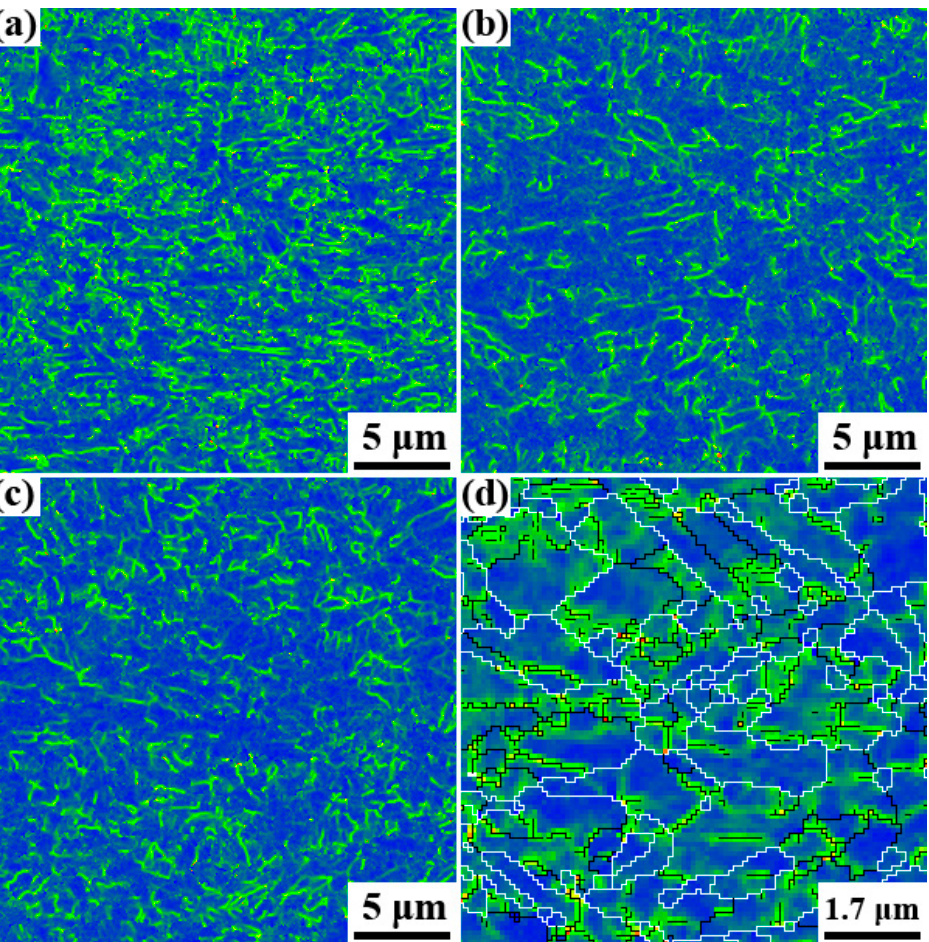
Figure 8. KAM map of specimen A ( a ), specimen B ( b ), specimen C ( c ), and a randomly chosen enlarged KAM map superposed with boundaries of specimen A ( d ), wherein the black line depicted the boundaries between 2° to 15° and the white line represented the boundaries over 15°.